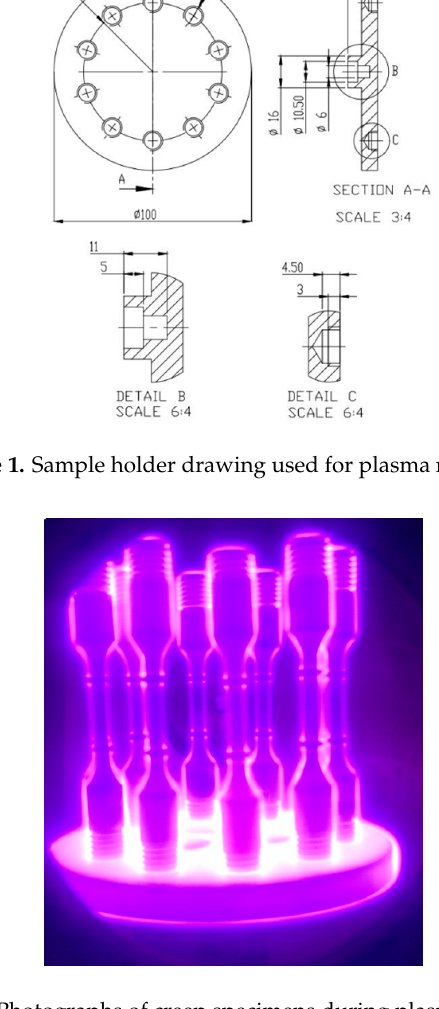
Figure 2. Photographs of creep specimens during plasma nitriding.